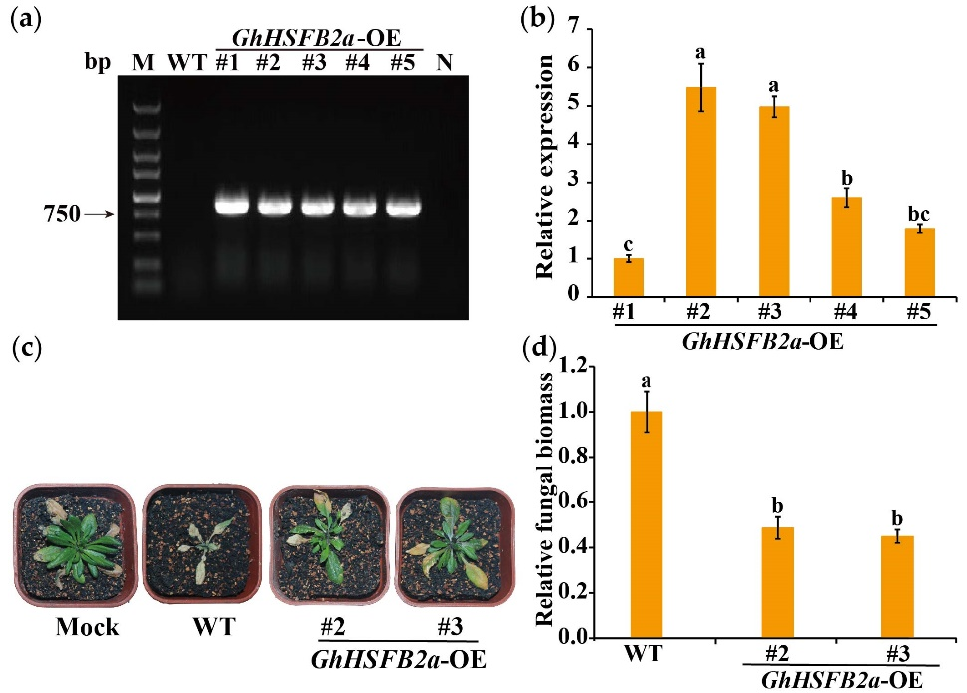
Figure 9. Enhanced V. dahliae resistance in A. thaliana plants overexpressing GhHSFB2a . ( a ) Positive transformants were identified using PCR amplification. M, maker; N, negative control. ( b ) Expression levels of GhHSFB2a driven by the 35S promoter in transgenic A. thaliana lines (L1, L2, L3, L4, and L5). Actin was used as an internal control. ( c ) Symptoms in WT and GhHSFB2a transgenic Arabidopsis plants inoculated with V. dahliae . ( d ) Fungal biomass determined using a qRT-PCR in WT and transgenic Arabidopsis plants. Error bars represent the standard deviations and different letters indicate significant differences at p < 0.05.